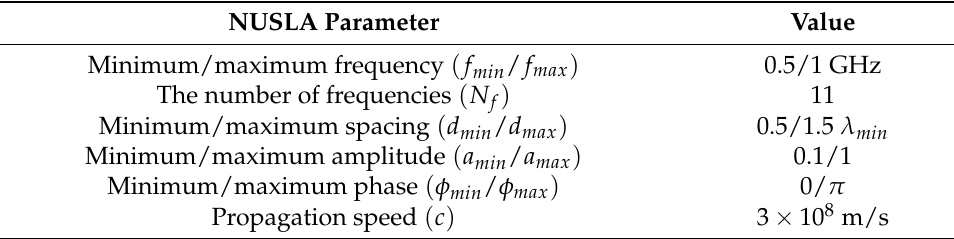
Table 1. NUSLA parameter